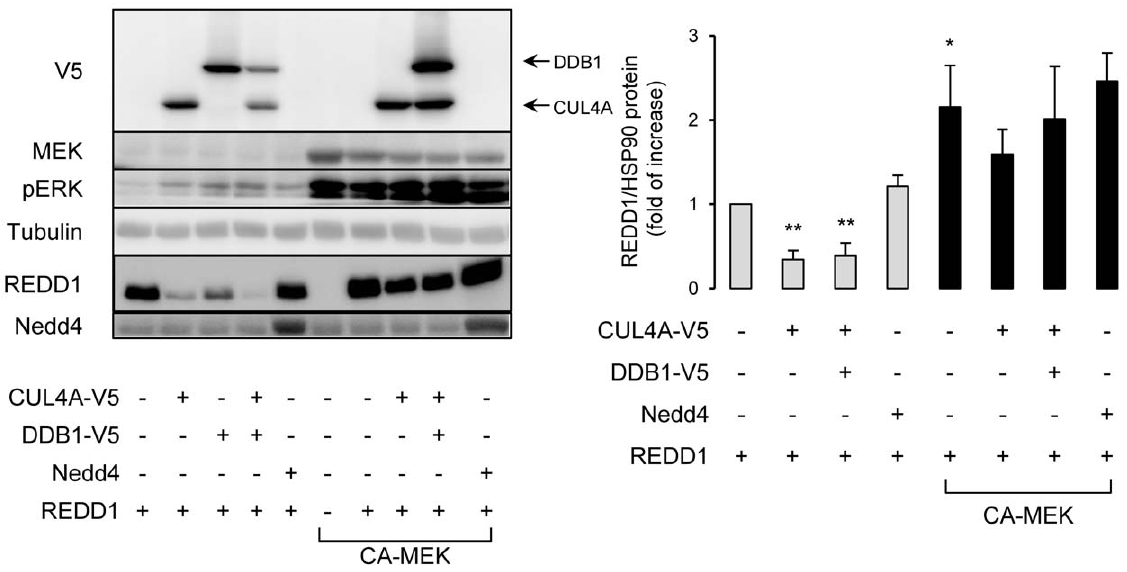
Figure 5. Constitutive active MEK inhibits CUL4A-induced REDD1 degradation. HEK-293 cells were transfected with indicated plasmids. 48 h after transfection, proteins were analyzed by immunoblots using indicated antibodies. REDD1 protein level is expressed compared to HSP90 expression and quantification of three independent experiments is shown (**p , 0.01). doi:10.1371/journal.pone.0052154.g005 on REDD1 stability in adipocytes and ectopic expression of expression. Insulin stimulates REDD1 expression through an constitutive active MEK mimics insulin effect on REDD1 increase of its transcription in adipocytes and in skeletal muscle